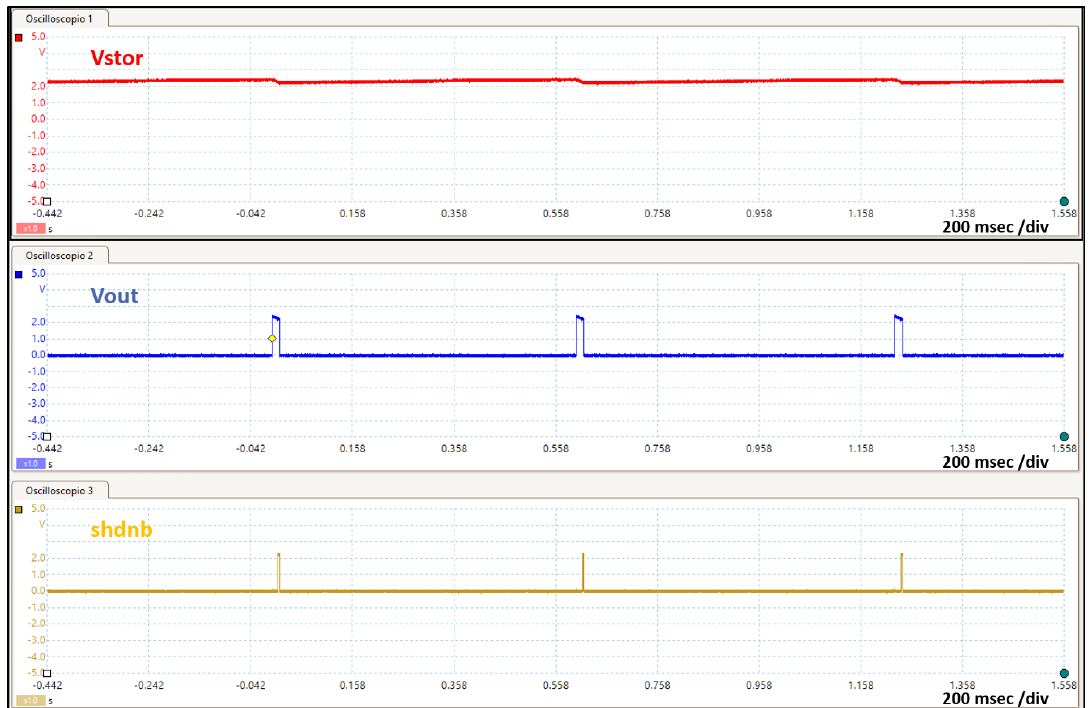
Figure 2. System on chip functional signals.